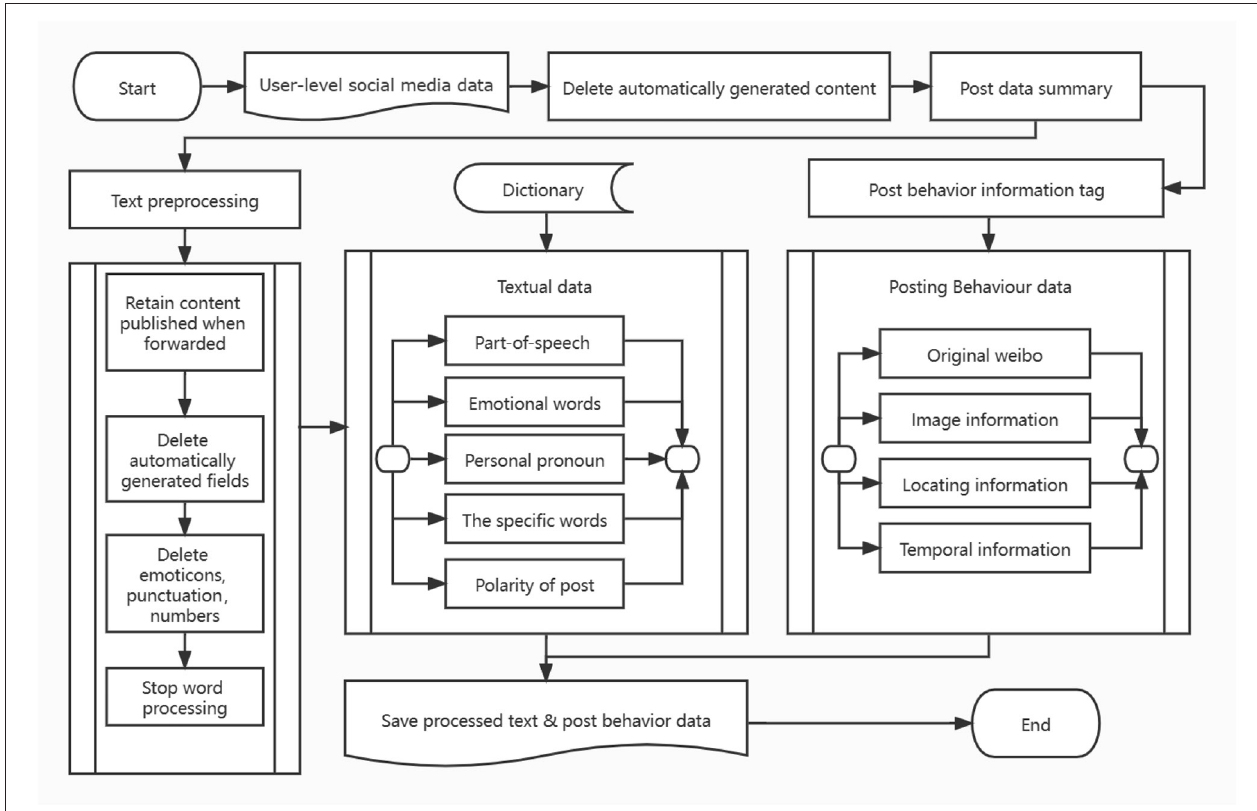
FIGURE 1 | Data preprocessing and feature